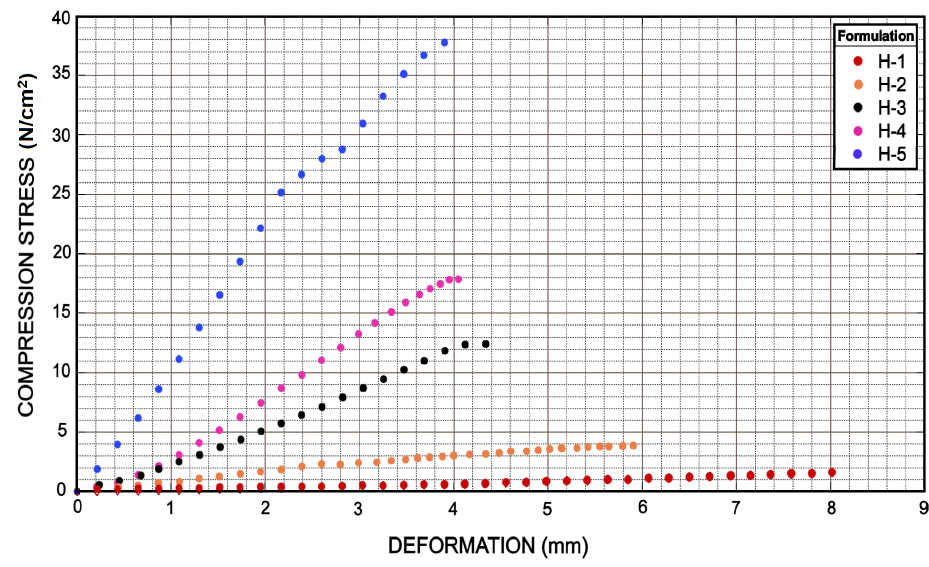
Figure 16. Compress test showed how much hydrogel samples were capable of deformation with respect to the force applied. Clearly H-5 showed a higher strength with a deformation very similar to H-3, while H-1 showed a very low strength in comparison with H-3 as well. However, H-1 was able to double the deformation presented by H-3 and H-5, which translates into greater flexibility. Furthermore, the average value of the Young’s module for the highest concentration of cross-linking agent (H-5) was 3.55 ± 0.22 MPa, approximately, which is 3 times higher than the H-3 sample and almost 50 times higher than H-1; Figure 17.